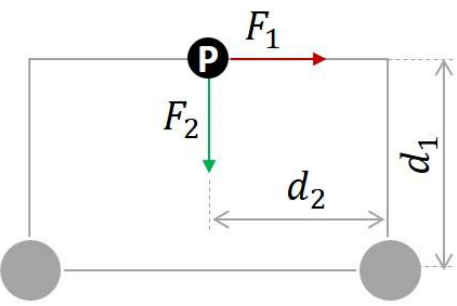
Figure 2. Forces and distances employed in MHS calculations (based on [12]).